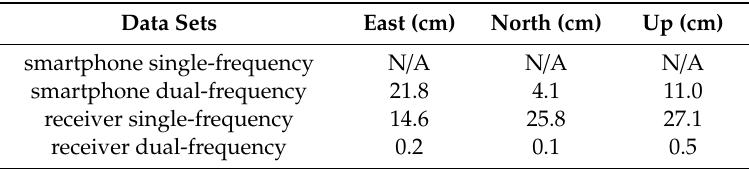
Table 4. RMS positioning errors of four data